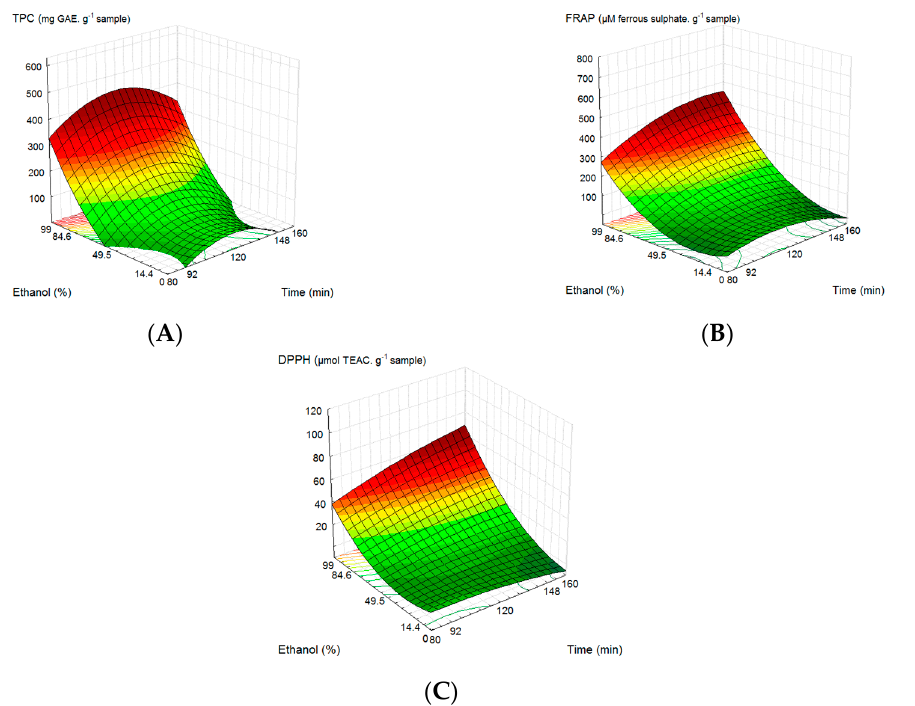
Figure 1. Response surfaces plots showing the effect of time and ethanol concentration on total phenolic content (TPC) and antioxidant capacity (FRAP and DPPH) represented by ( A ), ( B ) and ( C ), respectively.